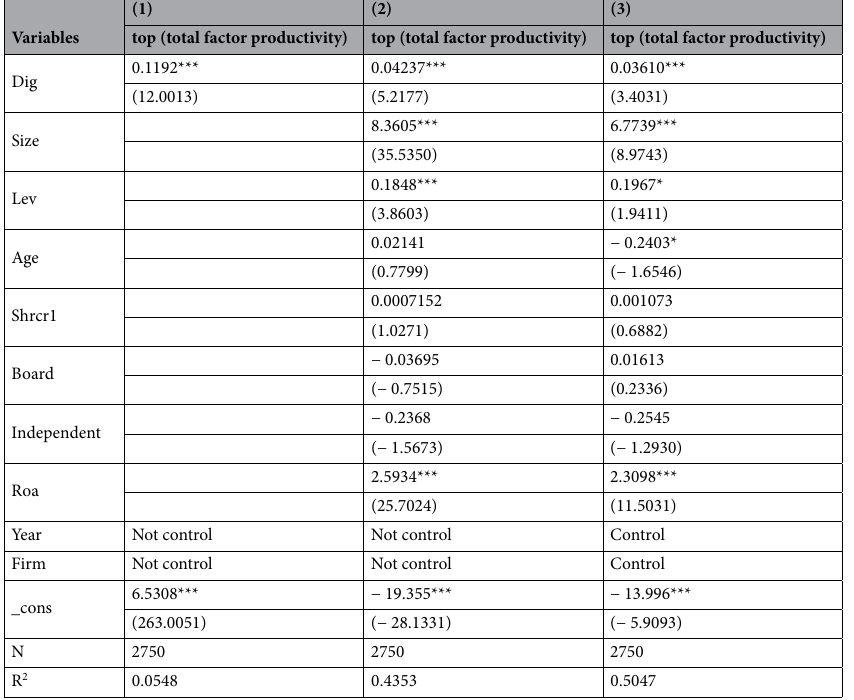
Table 6. Replace the regression result of the explained variable. T-statistics are shown in parentheses. ***, * indicate 1%, 10% respectively.